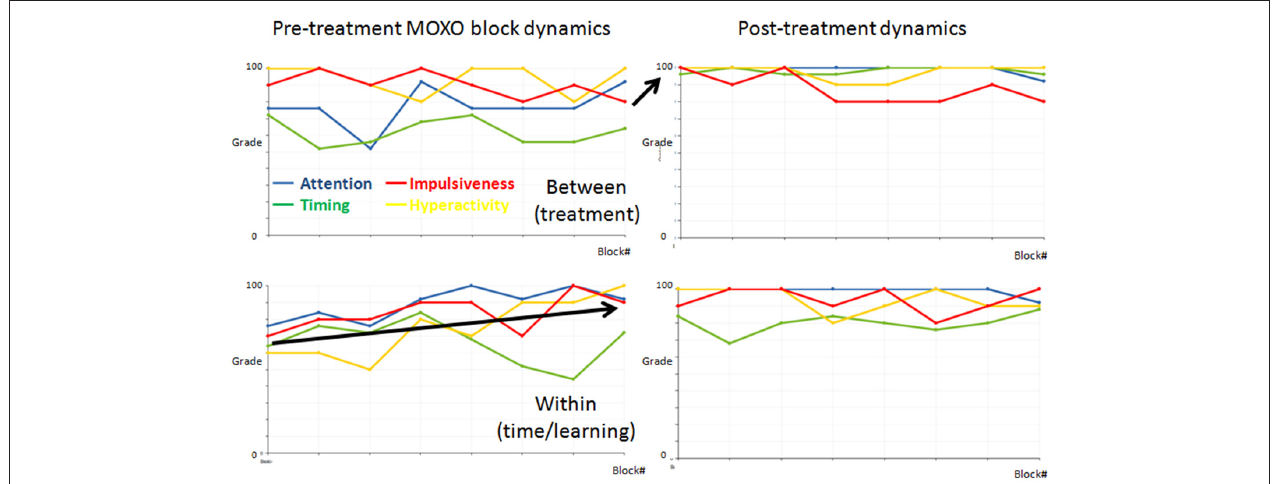
FIGURE 6 | Demonstrations of functional dynamics between the MOXOs and within the first MOXO. The dynamics of the four indices (attention = blue, timing = green, impulsiveness = red, and hyperactivity = yellow) between the eight blocks in the two MOXO sessions of two representative ADHD participants. The first and last blocks in each test are similar and are comprised of basic stimuli without distractors. Each participant’s dynamics is presented in a separate row. The left graphs present the pre-treatment, the right graphs the post-treatment MOXO session. Note that for the top participant the change occurred mainly between sessions. This is a representative participant of the treatment effect group. By contrast, for the bottom participant the change occurred mainly in the first pre-treatment session. This is a representative participant of the time/learning effect group.